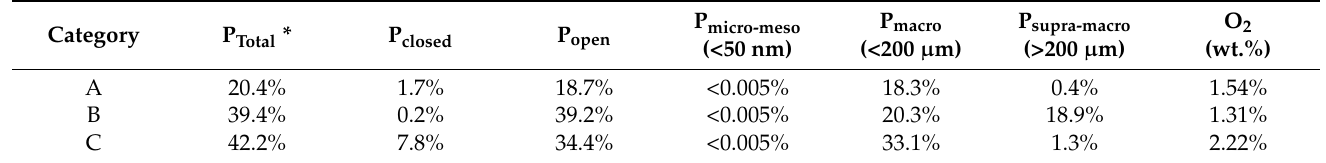
Table 6. Porosity characterization of the sintered Ti sponges including their associated oxygen content.